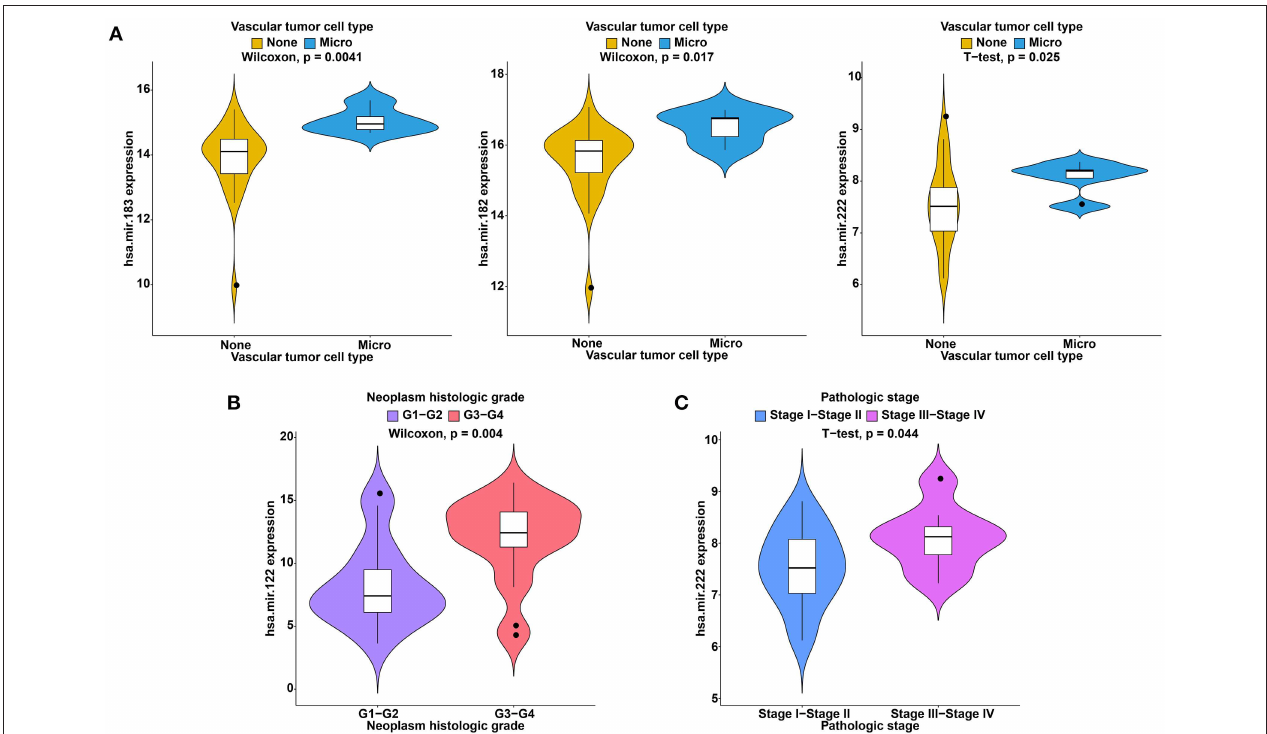
FIGURE 9 | Clinical feature analysis of DEmiRNAs in the ceRNA network. The correlation between DEmiRNAs involved in the ceRNA network and vascular invasion (A) , neoplasm histologic grade (B) and pathologic stage (C) .